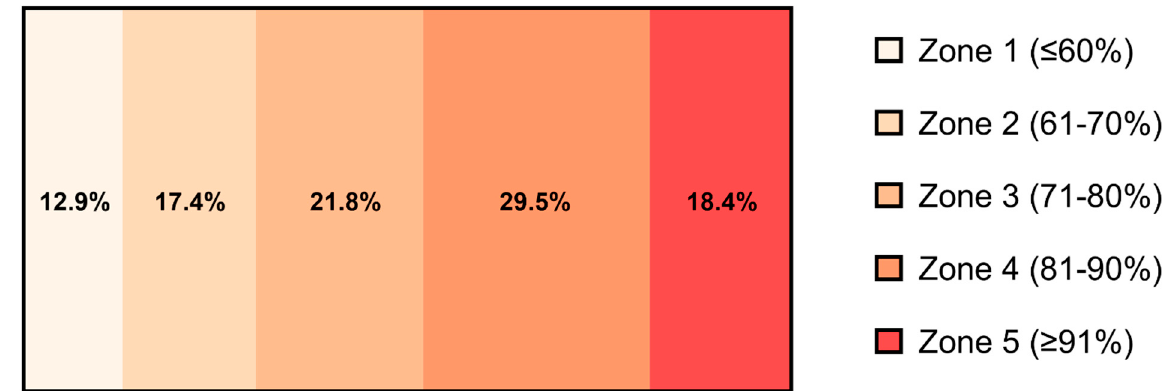
Figure 1. Average time spent in each training zone (%) over the 8-week high-intensity exercise train- ing period ( n = 13). The training zones were pre-defined by POLAR TEAM Pro. Zone 1 was ≤ 60% HR max , Zone 2 was 61 to 70% HR max , Zone 3 was 71 to 80% HR max , Zone 4 was 81 to 90% HR max , and Zone 5 was ≥ 91% HR max (Polar Electro Oy, Kempele,